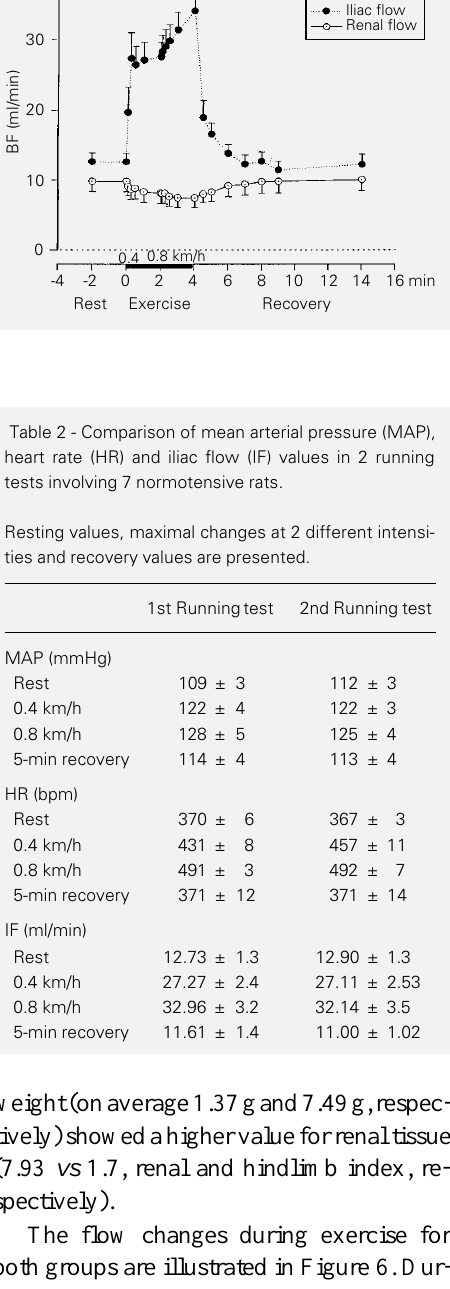
Figure 6 - Time-course changes of absolute regional flow (BF) (iliac, N = 7 and renal, N = 10) during 4 min of exercise (black bar) and during recovery.